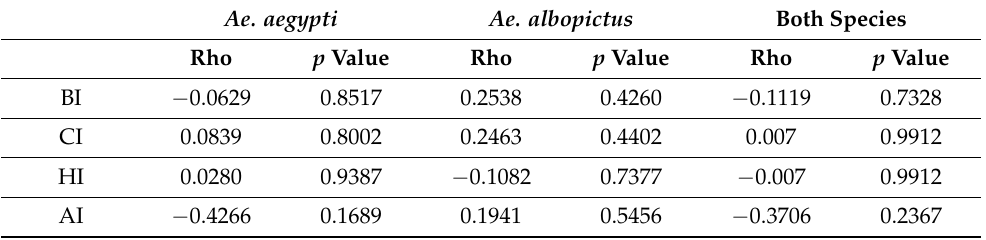
Table 5. Statistically significant correlations at 95% confidence between vectors IRs and epidemio- logical (reported cases) and virological (pathogen IRs) variables. No significant correlations were recorded for Ae. albopictus species.